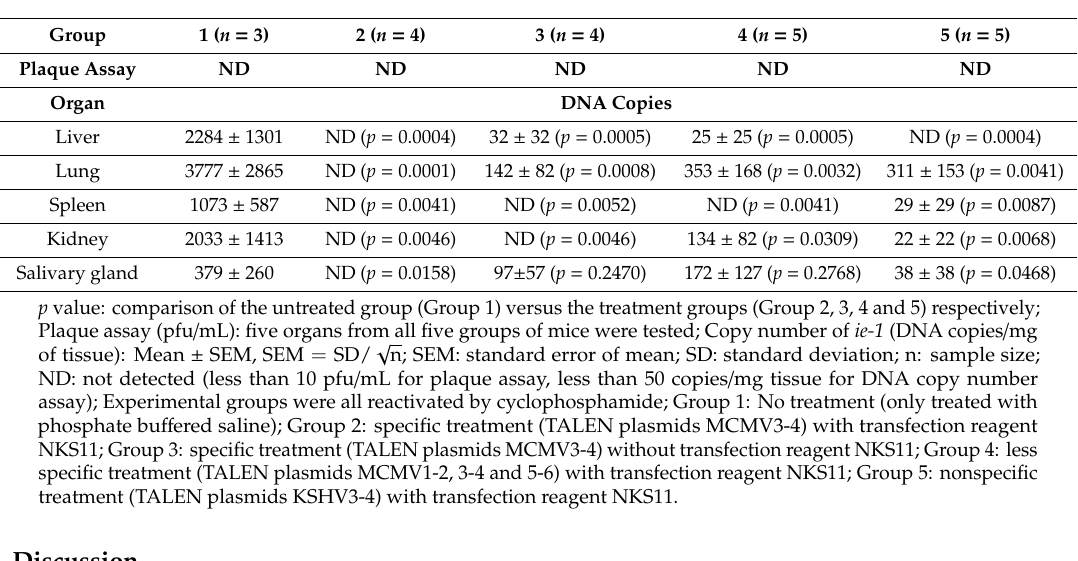
Table 4. Assay of MCMV-infected mouse organs for TALEN